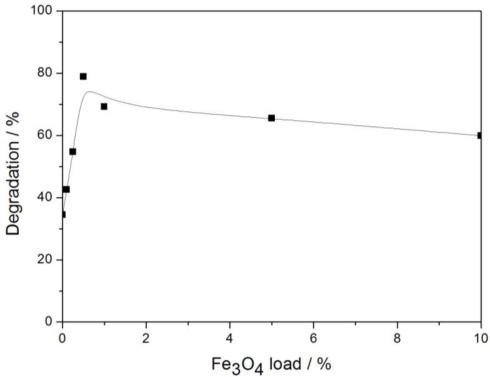
Effect of Fe3O4 load on glyphosate degradation.